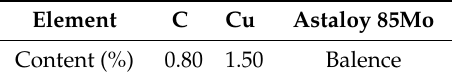
Table 1. Chemical composition of the PM (powder metallurgy)